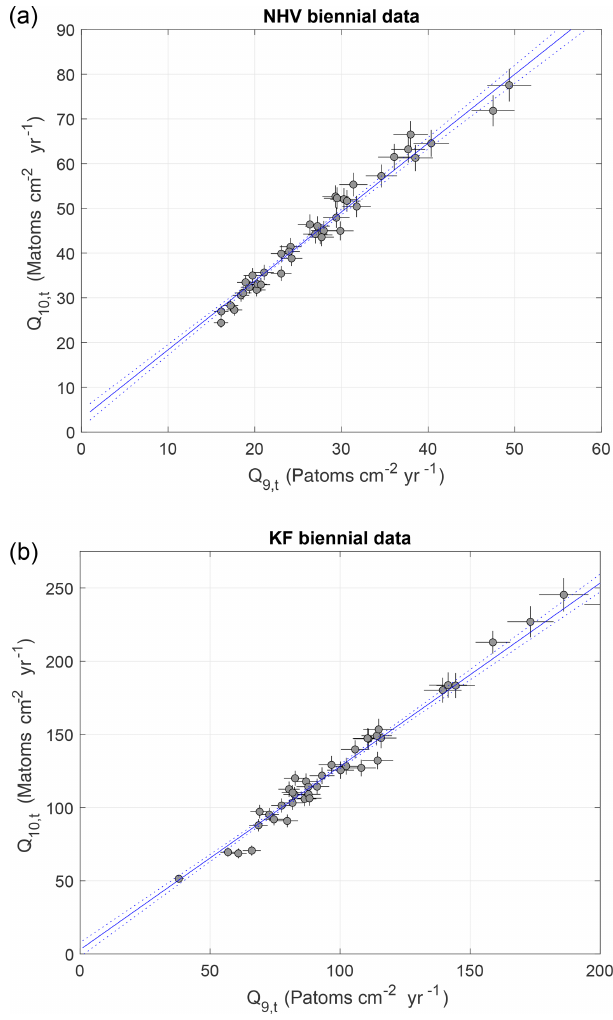
Figure 13. Plots showing regression of 10 Be against 9 Be fluxes for NHV and KF biennial data. Following Eq. (1), the y intercept should give the mean 10 Be fallout flux. It is evident that, although this is above zero (as it should be), it is small compared to total 10 Be fluxes and comparable in magnitude to measurement uncertainty and scatter around the line. The dotted lines show a 68% confidence interval for the regression derived from a Monte Carlo